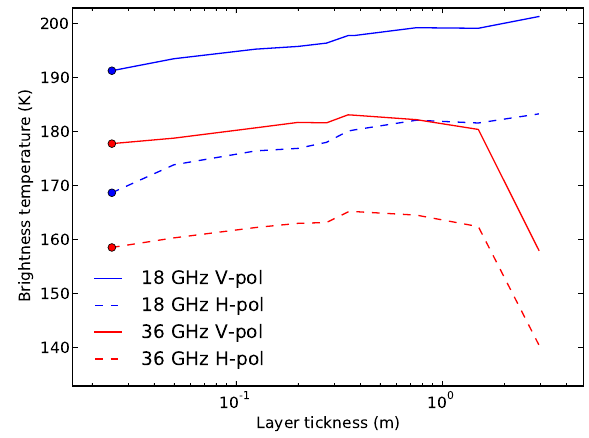
Fig. 10. Brightness temperature at 18.7 and 36.5GHz at Dome C, Antarctica, simulated as a function of the resolution of the pro- files of grain size and density. The original profiles are presented in Brucker et al. (2011a) and are composed of two parts: the upper 3m were measured with a vertical resolution of 2.5cm (simulation marked by a symbol) and the lower part (3 to 100m depth) is a de- terministic function of the depth. The profiles at lower resolutions are generated by merging successive layers in the upper part only to emphasize the influence of measured profile resolution, the lower part remaining unchanged. The x axis reports the thickness of the layers, from 2.5cm (original profile) to 3m (i.e. one single layer for the upper